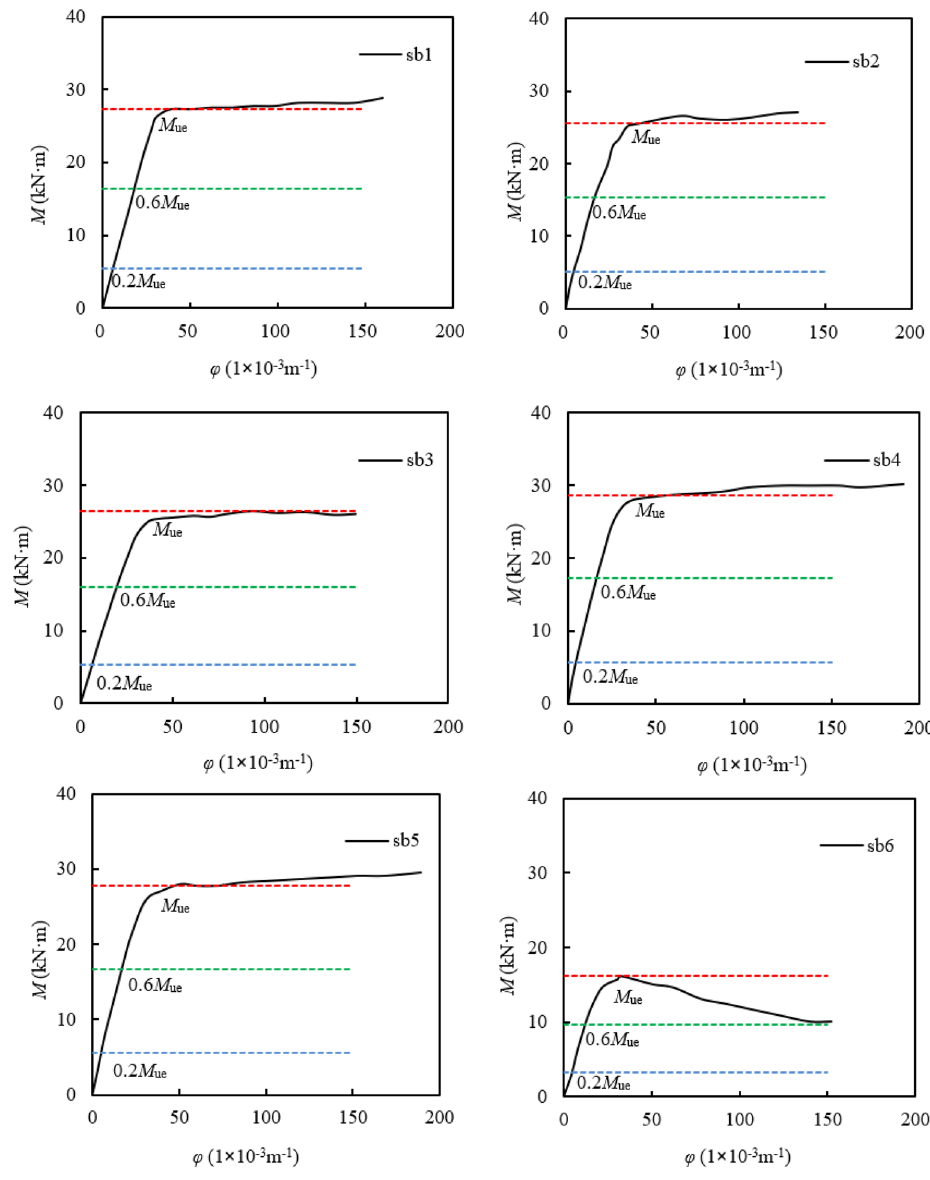
Figure 6. Bending moment (M) -curvature (φ)